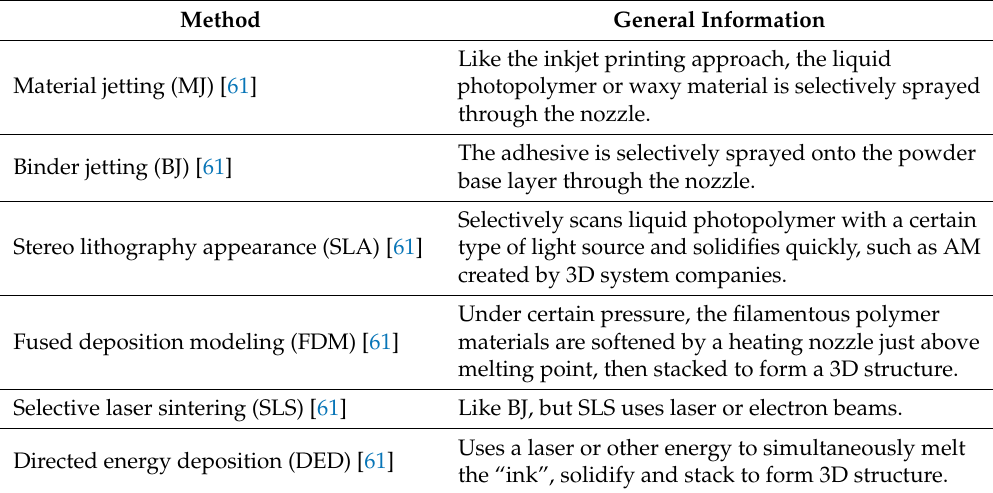
Table 5. Further 3DP technology information from sample papers